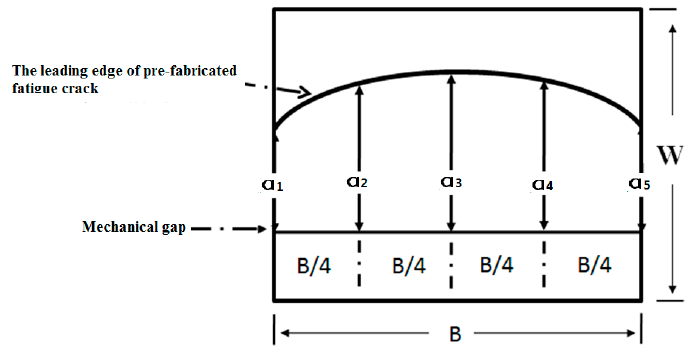
Figure 6. Diagrammatic sketch of the crack length measurement.